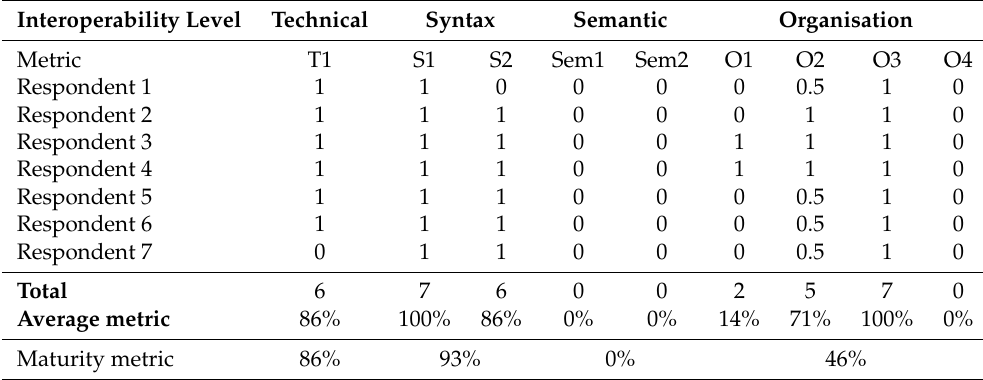
Table 2. Interoperability maturity (see Tables 1 and